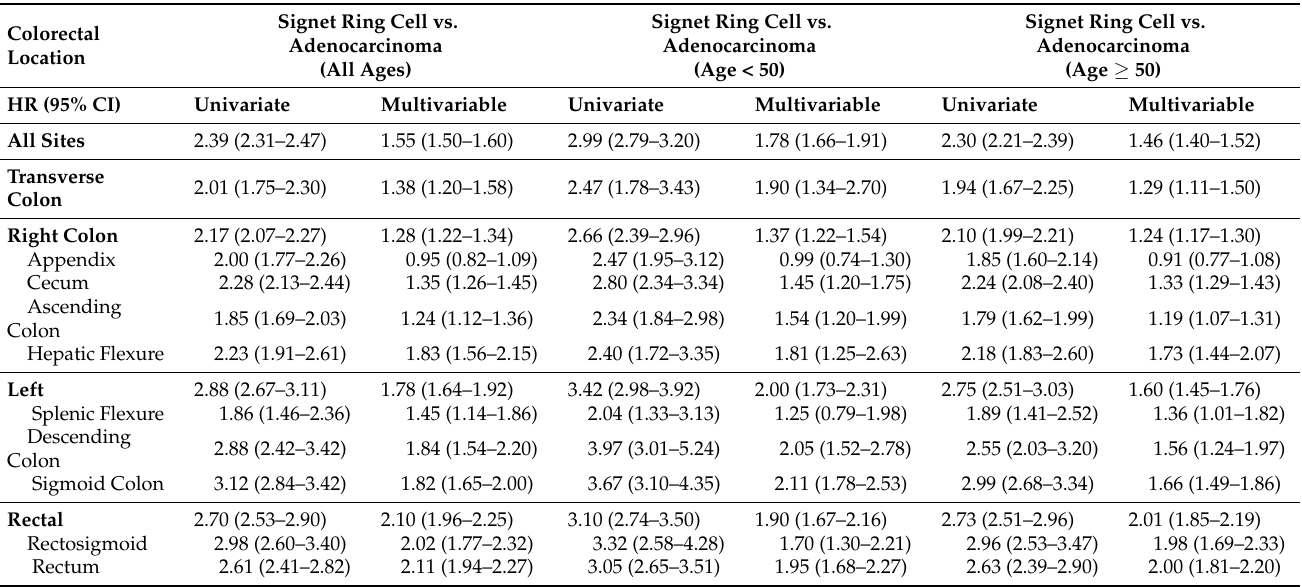
Table 6. Derived univariate and multivariable Cox-proportional hazard ratios of mortality for colorectal signet ring cell adenocarcinomas versus conventional